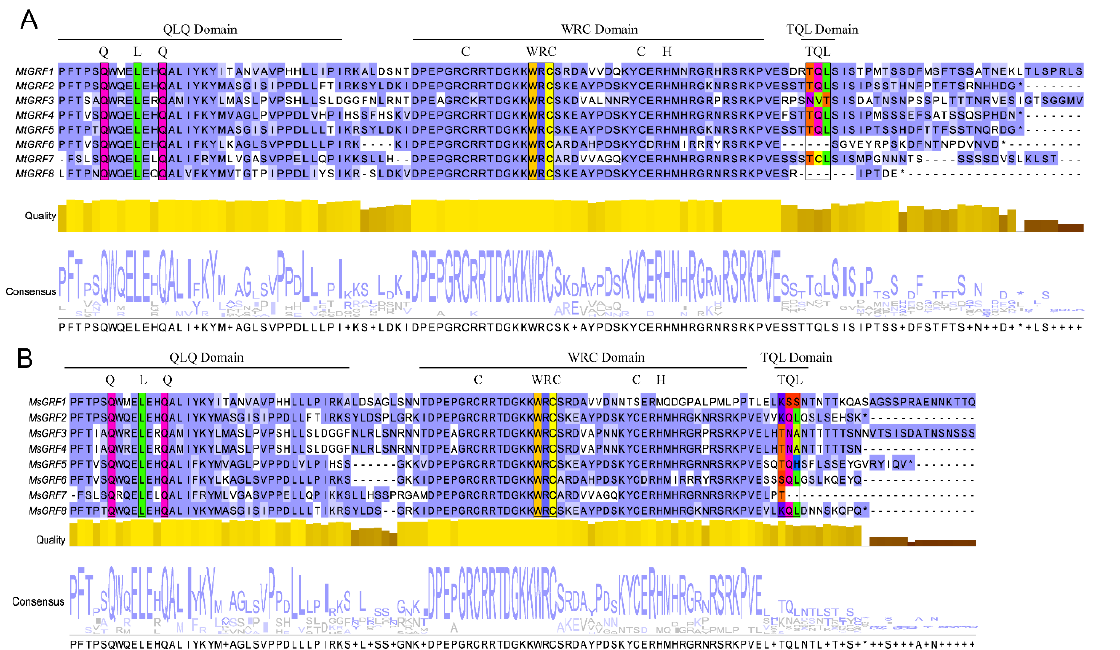
Figure 1. Multiple sequence alignment of MtGRFs ( A ) and MsGRFs ( B ). The result only showed partial sequences containing the QLQ, WRC and TQL domains. The alignment was constructed by using MEGA-X and visualized by using Jalview. Residues with more than 50% similarity were shaded. Conserved regions (QLQ, WRC, and TQL) were indicated at the top.